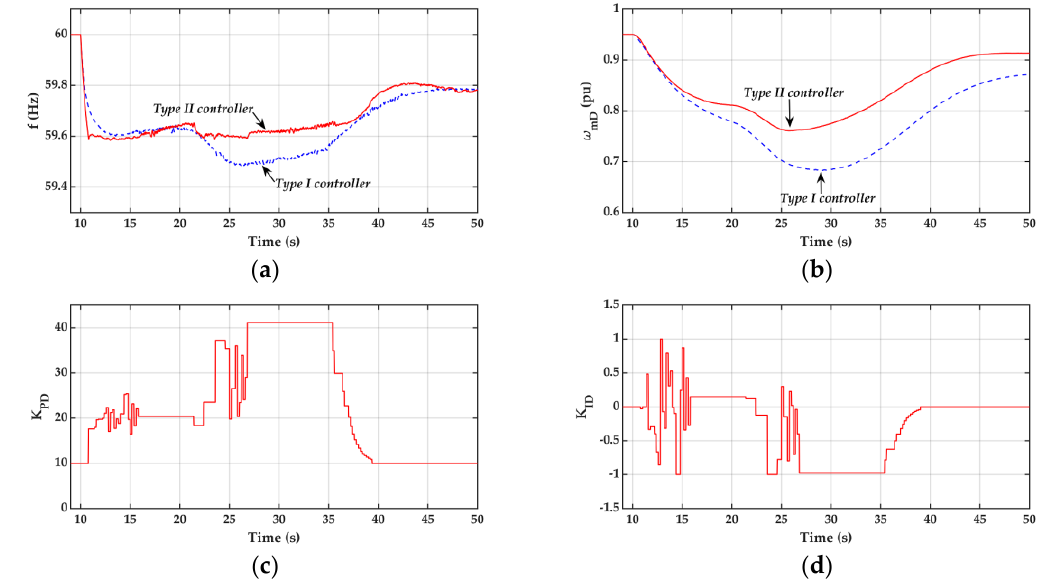
Figure 12. Comparison of dynamic response curves from the Type I and Type II controllers under change of wind speed ( P grid = 45 MW). ( a ) Frequency, ( b ) DFIG speed, ( c ) PSO proportional gain, ( d ) PSO integral gain.